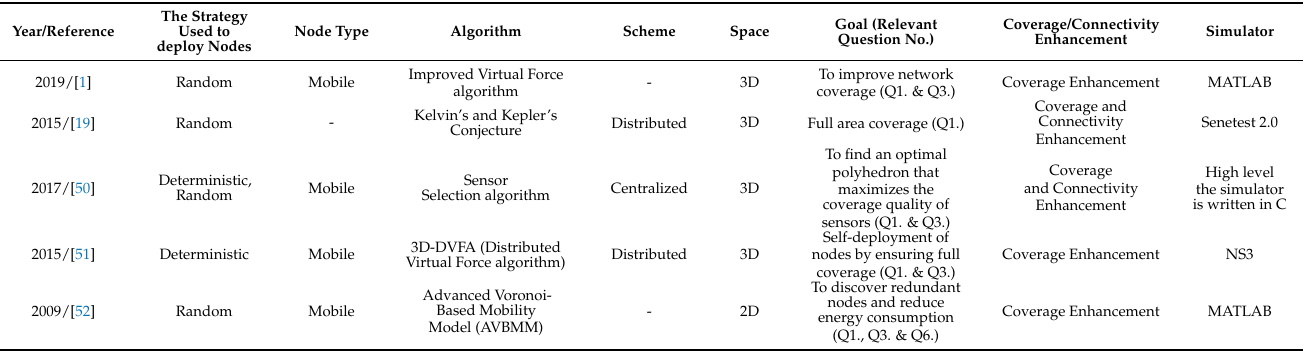
Table 4. An Overview of Different Voronoi Tessellation-Based Techniques to Improve Coverage and Connectivity in WSNs.